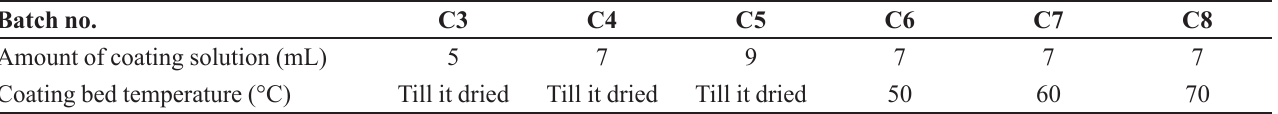
TABLE VI - Optimization of the coating variables Batch